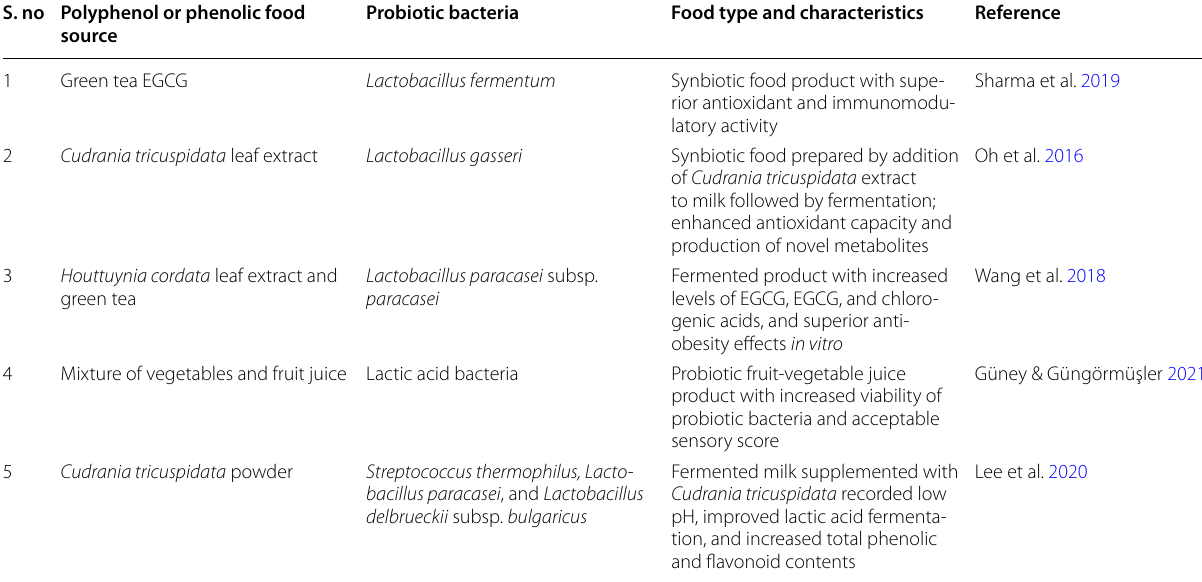
Table 2 Representative examples of novel functional foods prepared by probiotic fermentation of